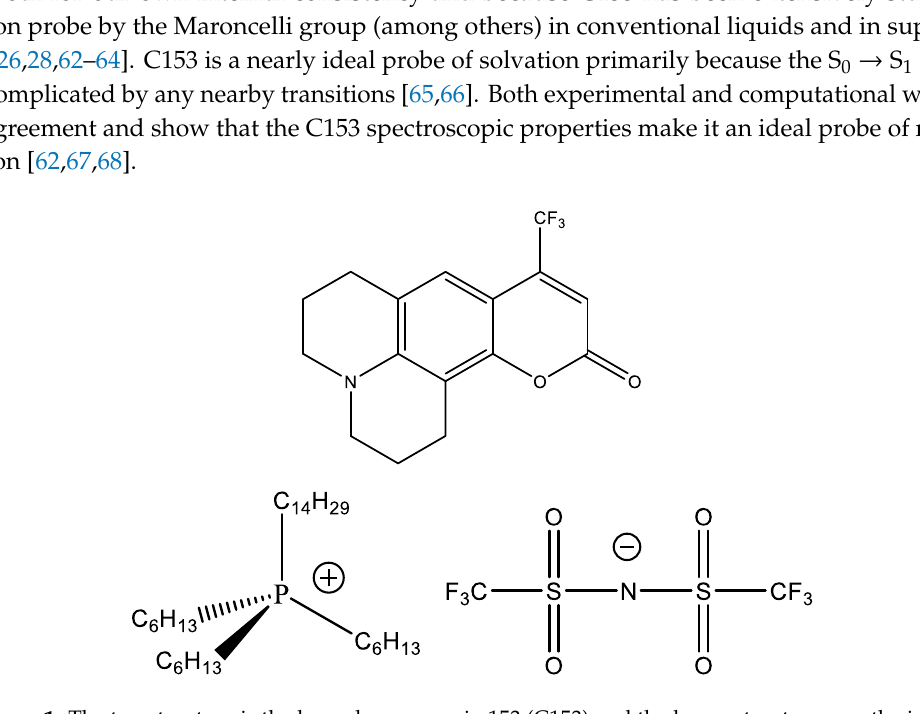
Figure 1. The top structure is the laser dye coumarin 153 (C153) and the lower structures are the ions in trihexyltetradecylphosphonium bis(trifluoromethylsulfonyl)imide [P 6,6,6,14 ] + [Tf 2 N] −